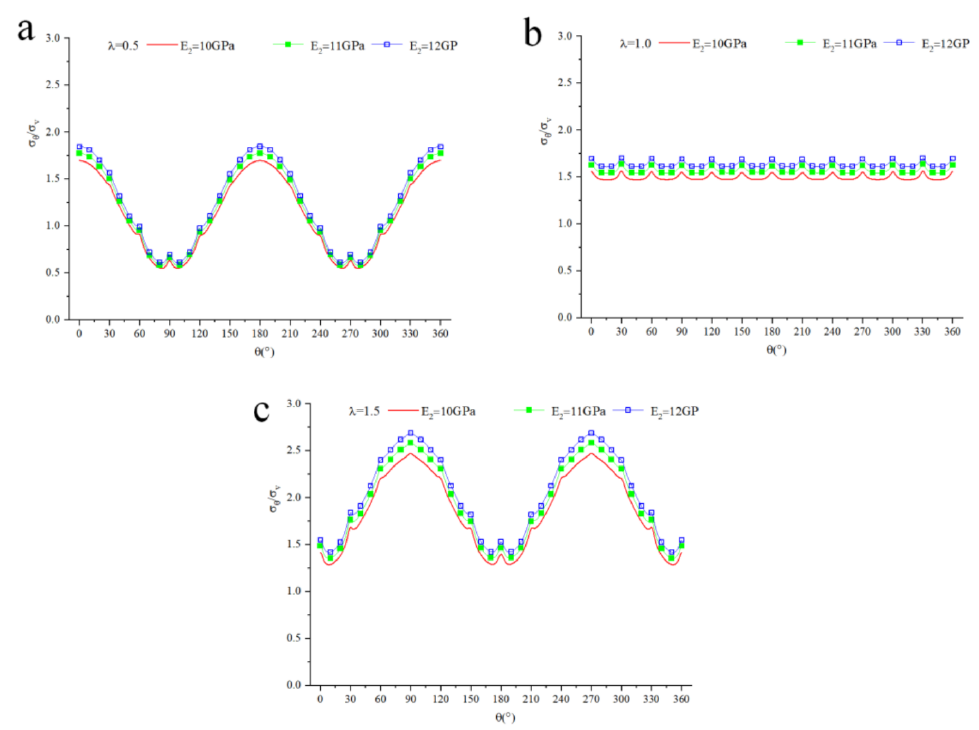
Figure 11. Tangential stresses for the points at L − with different E 2 (( a ) λ = 0.5, ( b ) λ = 1.0, ( c ) λ =